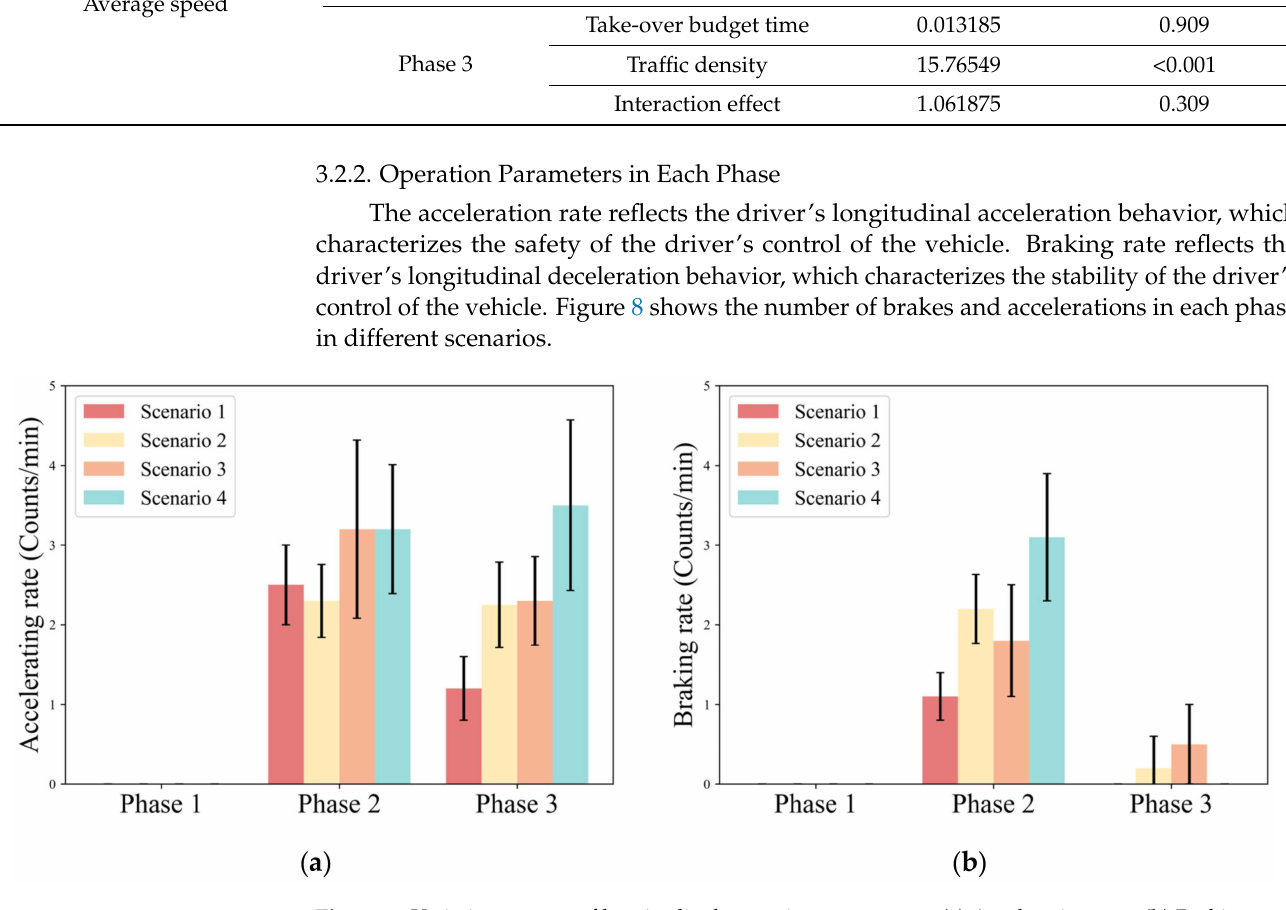
Figure 8. Variation pattern of longitudinal operation parameters. ( a ) Accelerating rate; ( b ) Braking